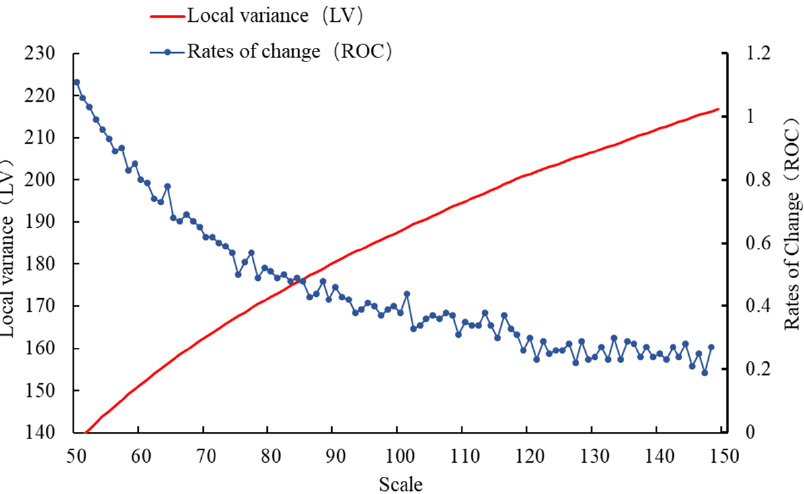
Figure 4. ROC curve of the ESP2 parameter calculation.